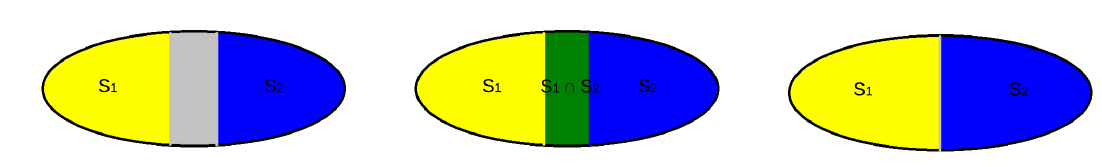
Figure 2. Area division between two identical agents. Yellow, blue and gray indicate the area assigned to the first UAV, the second UAV and unassigned, respectively. Image on the left shows a sub-optimal division where S 1 ∪ S 2 (cid:54) = S . Image in the middle shows a sub-optimal division because S 1 ∩ S 2 (cid:54) = ∅ . Image on the right shows an optimal area division matching the conditions shown in Equation (1).